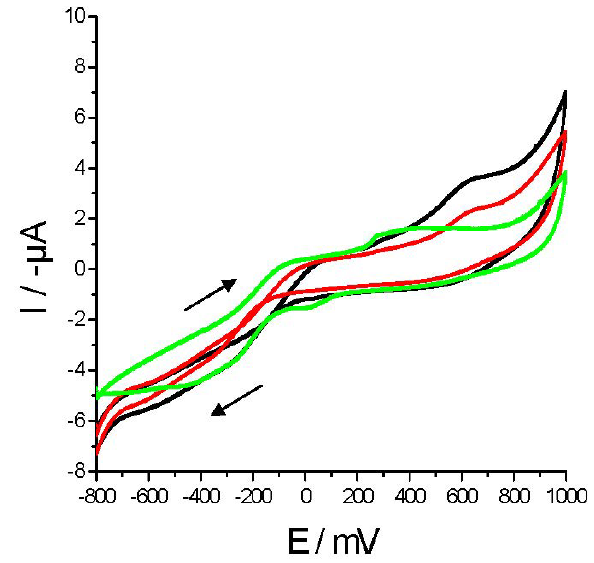
Figure 2. Cyclic voltammetries performed with Au WE over urea adulterated and non-adulterated milk samples: M (black curve); USM Adulterant concentrations were 12.14 g·L − 1 ( USM scan direction is indicated by a black